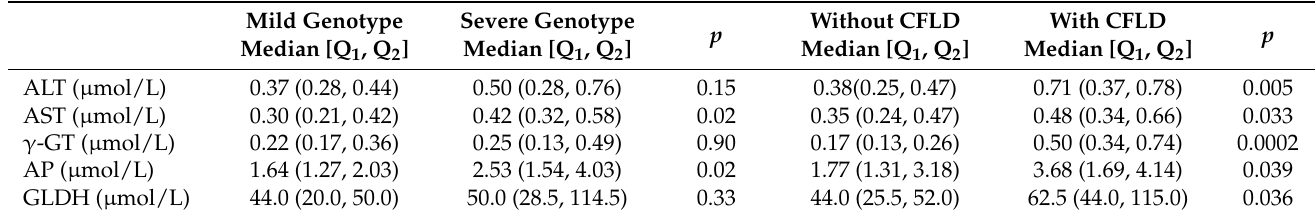
Table 4. Median concentrations of serum biochemical parameters alanine aminotransferase (ALT), aspartate aminotransferase (AST), γ -glutamyl transpeptidase ( γ -GT), alkaline phosphatase (AP), and glutamatdehydrogenase (GLDH) (median and [Q 1 , Q 3 ]).